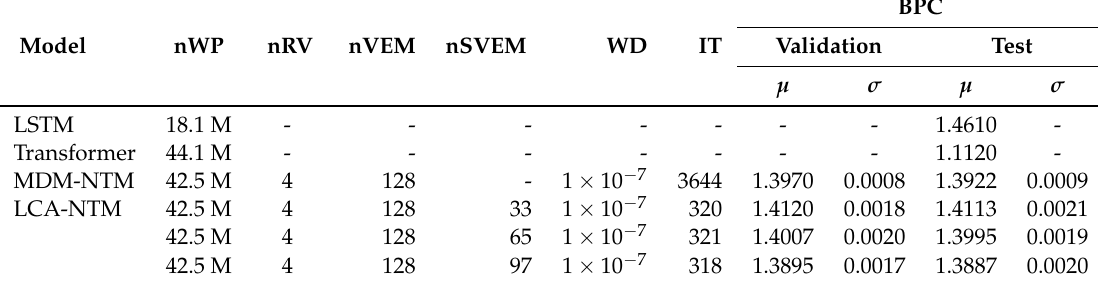
Table 4. Evaluation results of LCA-NTM-based LM according to number of selected memory addresses on the enwik8 LM task (nWP, number of weight parameters; nRV, number of read vectors; nVEM, number of vectors in the external memory; nSVEM, number of selected vectors in the external memory; WD, weight decay; IT, inference time (ms/batch); µ , mean of BPC results; σ , standard deviation of BPC